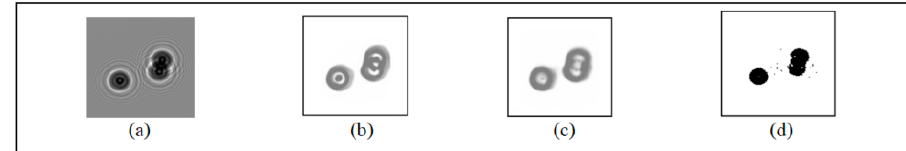
Figure 7. Comparison results: ( a ) original image ( b ) result of CSnet ( c ) result of Unet ( d ) result of the self ‐ adaptive threshold algorithm.